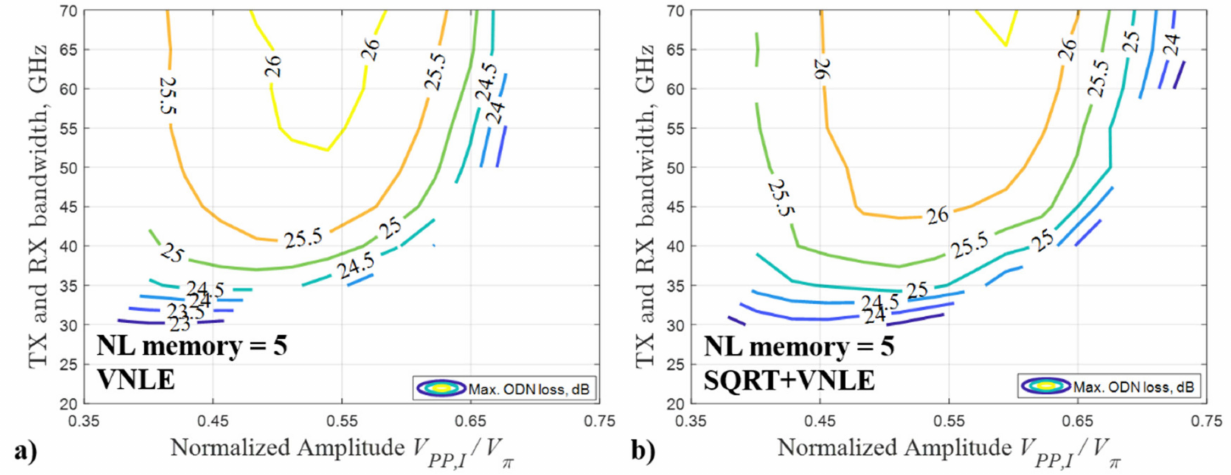
Figure 2. Maximum ODN loss at BER T = 10 − 2 as a function of TX and RX bandwidth and of the normalized peak-to-peak amplitude of the in-phase signal V PP , I / V π with NL memory = 5 samples. The fiber length is L = 20 km. The transmitted optical power is TOP = 15 dBm: ( a ) VNLE; and ( b ) SQRT + VNLE.